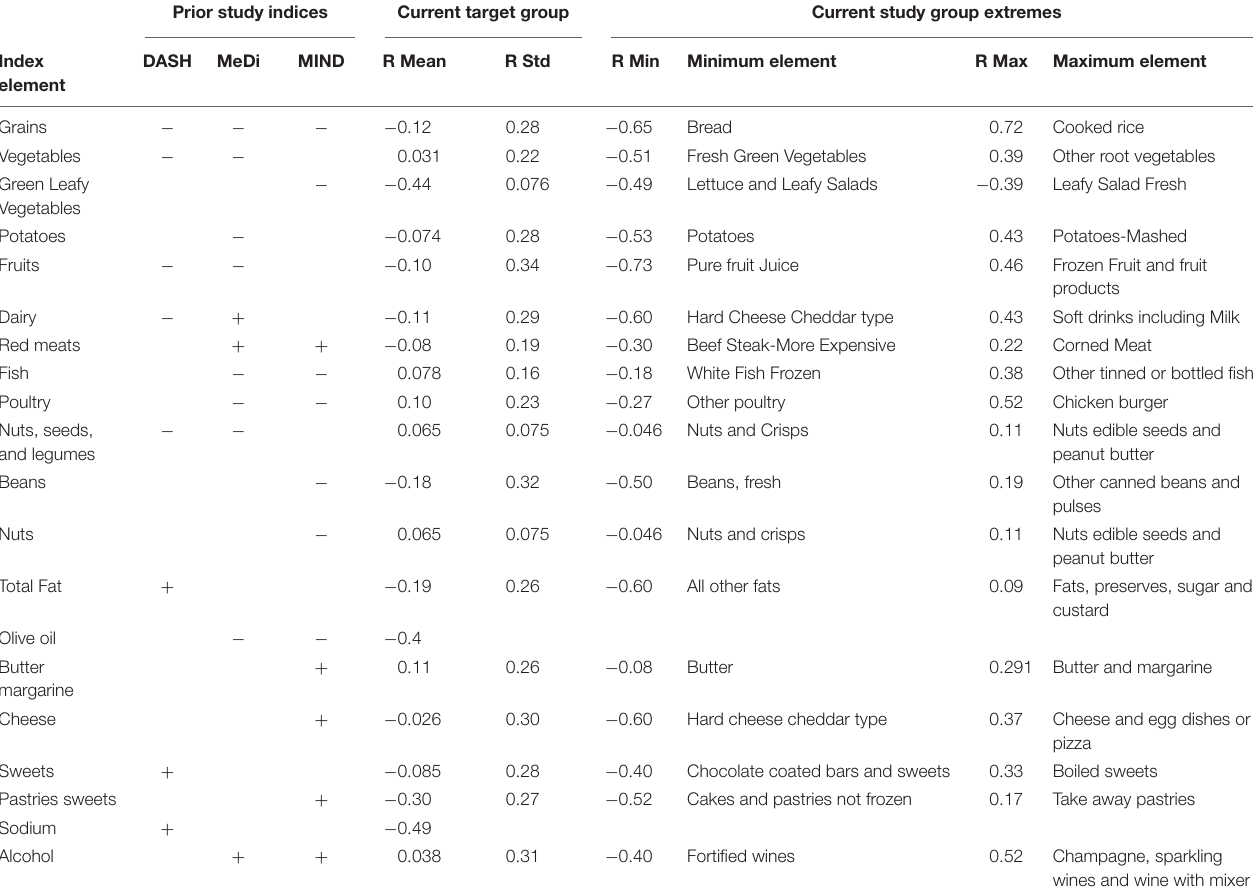
TABLE 3 | Comparison of index elements in the DASH, Mediterranean and MIND diets (Morris et al., 2015) that are also in the current